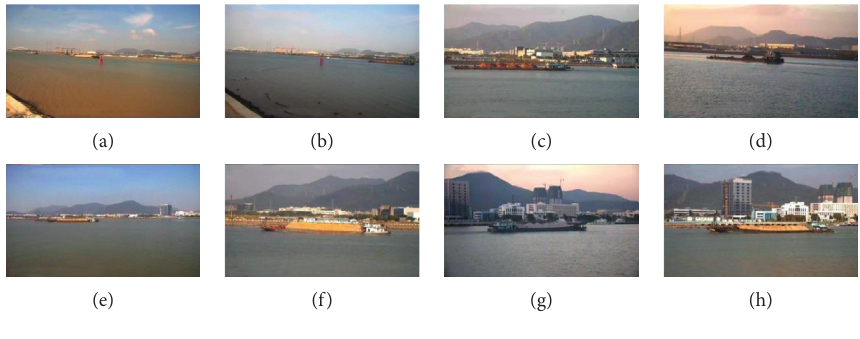
Figure 8: Dataset by seaships.